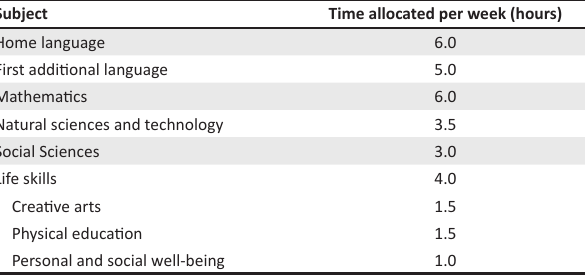
TABLE 1: Intermediate Phase subject and time allocations.